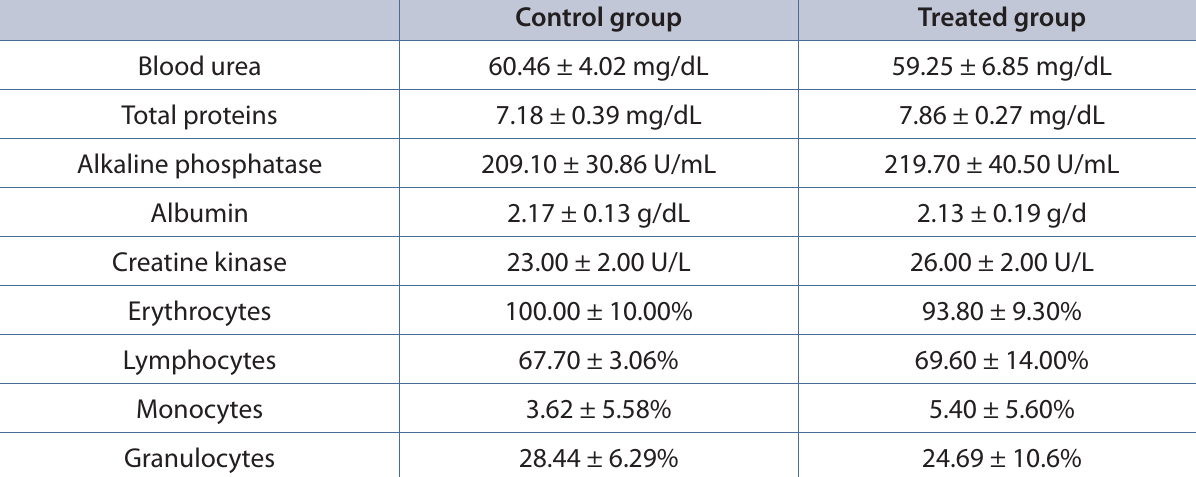
Table 2. Biochemical and hematological analysis of mice treated with the therapeutic CV dose established in